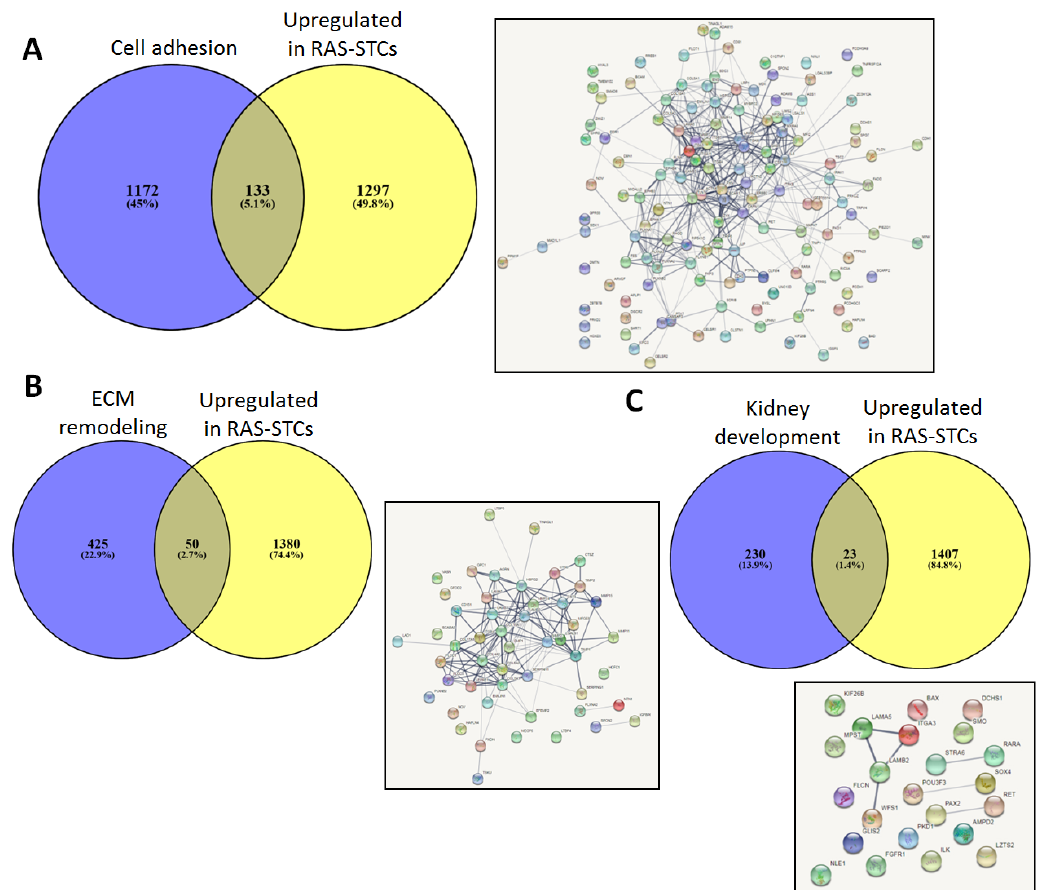
Figure 5. Venn diagram analysis (Venny 2.1) indicated that 133 cell adhesion ( A ) 50 extracellular matrix remodeling ( B ) and 23 kidney development ( C ) genes were upregulated in renal artery stenosis (RAS)-scattered tubular-like cells (STCs). Search Tool for the Retrieval of Interacting Genes (STRING) was used to predict associations between these genes.